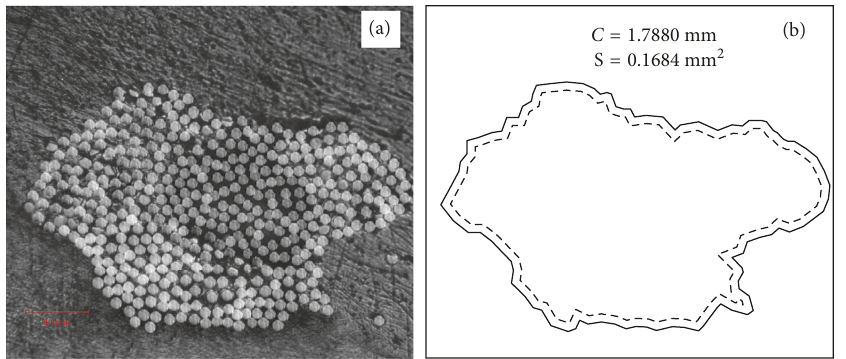
Figure 8: Graph division and calculation of C and S for a cluster fiber. Table 3: Calculated values of c and S for the j th fiber clustering with different fiber volume